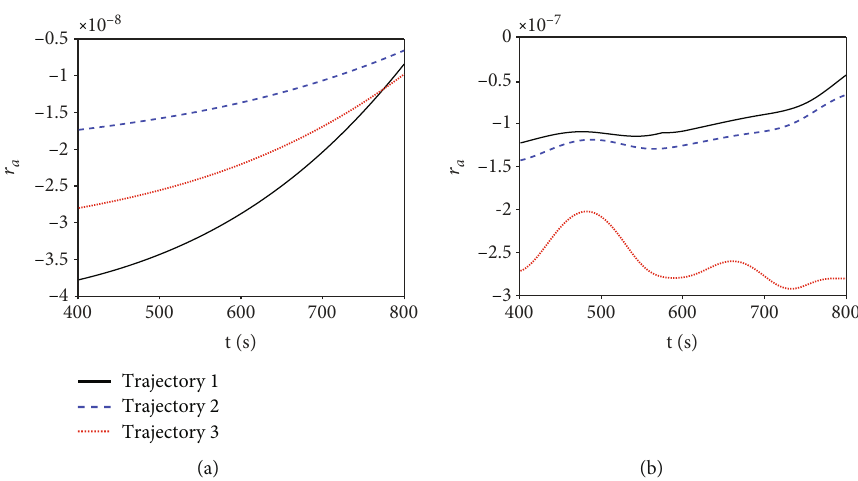
Figure 4: The variation of r